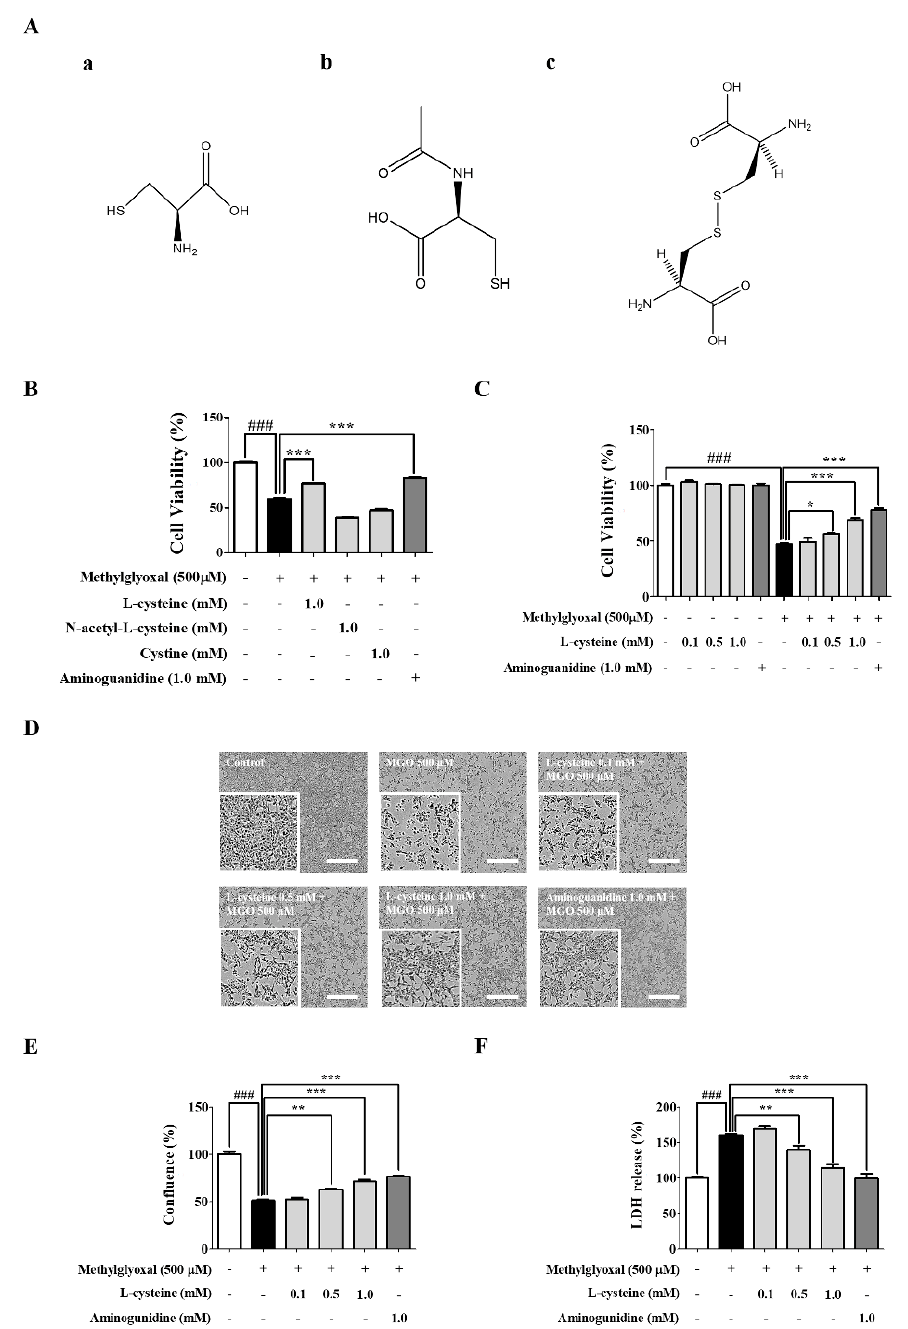
Figure 1. Effects of L -cysteine on methylglyoxal (MGO)-induced cell toxicity in MES13 cells. ( A ) Chemical structure of ( a ); L -cysteine, ( b ); N -Acetyl- L -cysteine (NAC), ( c ); Cystine. ( B ) Cell viability of MES13 cells treated with MGO (500 μ M) and equal concentrations (1.0 mM) of L -cysteine, NAC, and cystine. ( C ) Cell viability of MES13 cells treated with MGO (500 μ M) and various concentrations of L -cysteine (0.1, 0.5, and 1.0 mM) and analyzed using the MTT assay. ( D ) Representative photographs of L -cysteine pre-treatment protection against MGO-induced cytotoxicity. Scale bar indicates 500 μ m. ( E ) Quantitative measurements of confluence were evaluated using IncuCyte Zoom imaging system. ( F ) MGO-induced LDH production was evaluated by LDH assay in MES13 cells. All data are presented as mean ± SEM. n = 3 (### p < 0.001 vs. Control, * p < 0.05, ** p < 0.01, *** p < 0.001 vs. MGO 500 μ M).